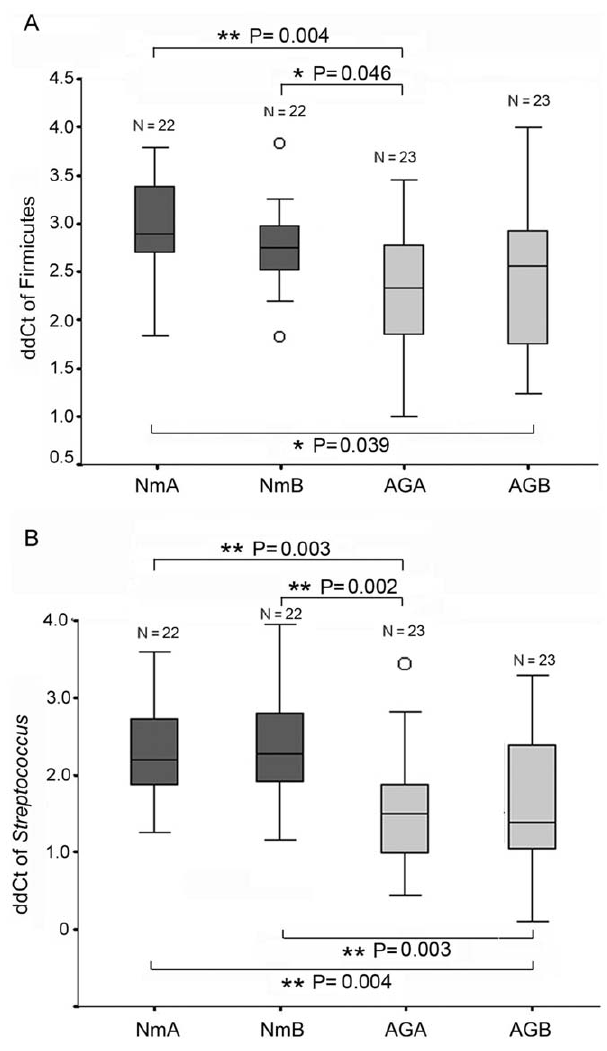
Figure 3. Abundance of the Firmicutes phylum and the Streptoccous genus in different biopsies. Delta delta Ct (ddCt) values (see text for details) were used to represent the abundance of the two taxa. A higher ddCt value represents a lower abundance of the taxon (abundance=2 2 ddCt